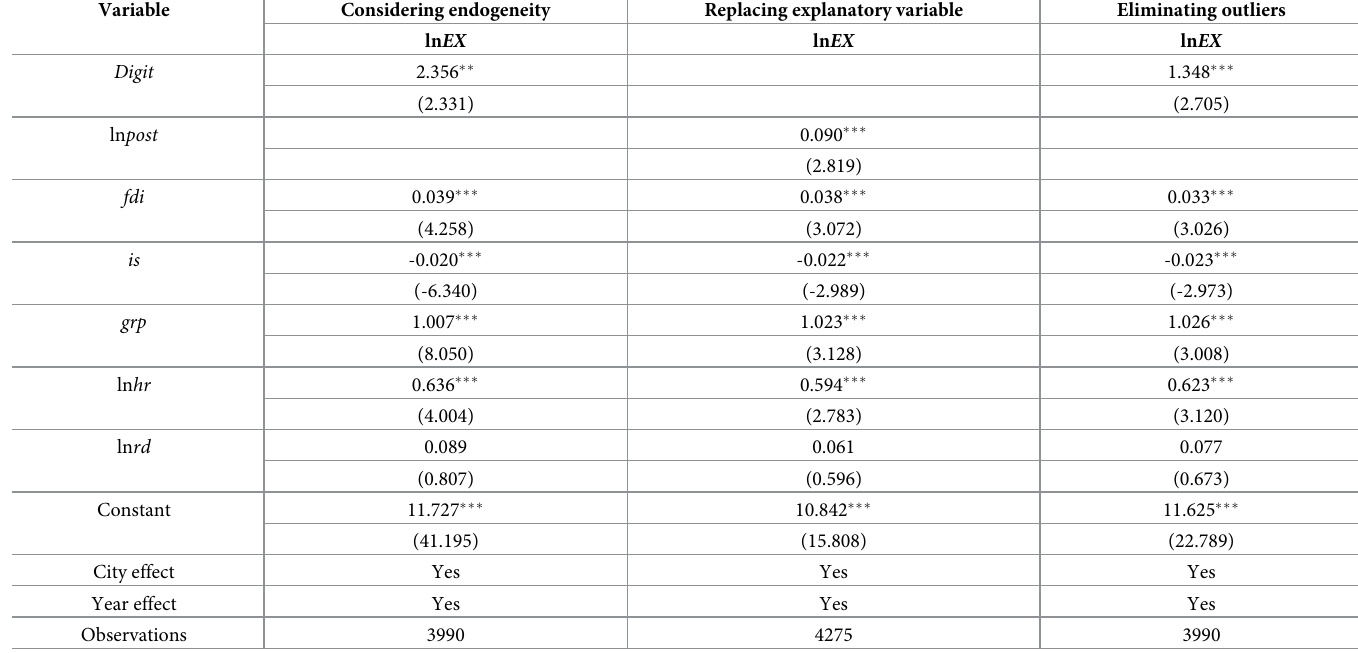
Table 3. Results of robustness test of the benchmark